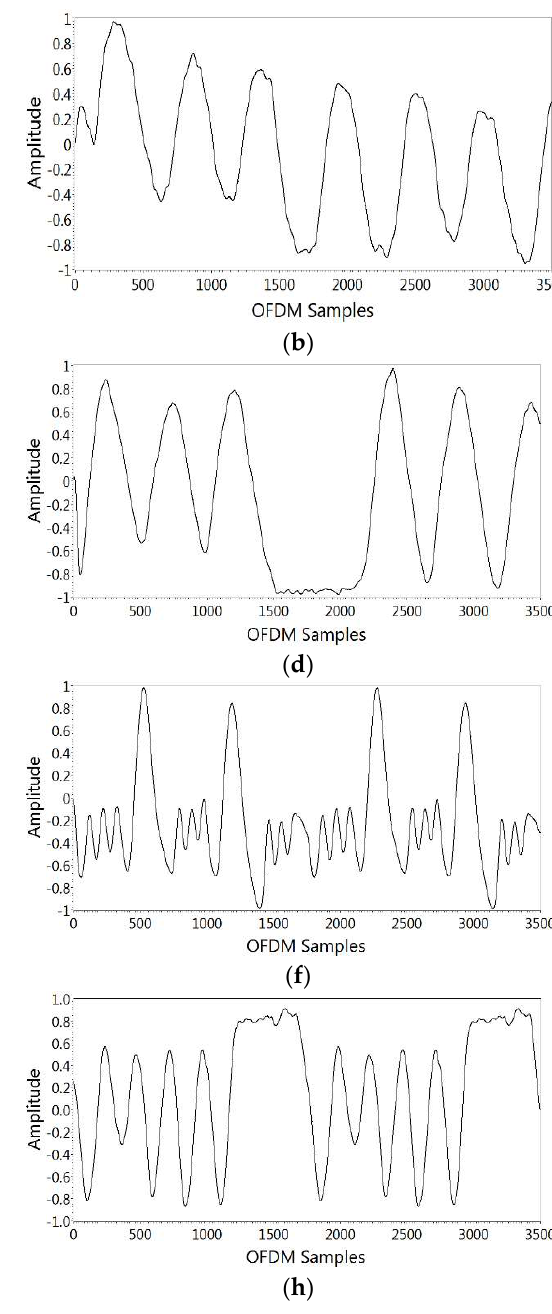
Figure 7. Breathing pattern results. ( a ) Eupnea, ( b ) bradypnea, ( c ) tachypnea, ( d ) Biot, ( e ) sighing, ( f ) Cheyne–Stokes, ( g ) Kussmaul, ( h ) CSA.